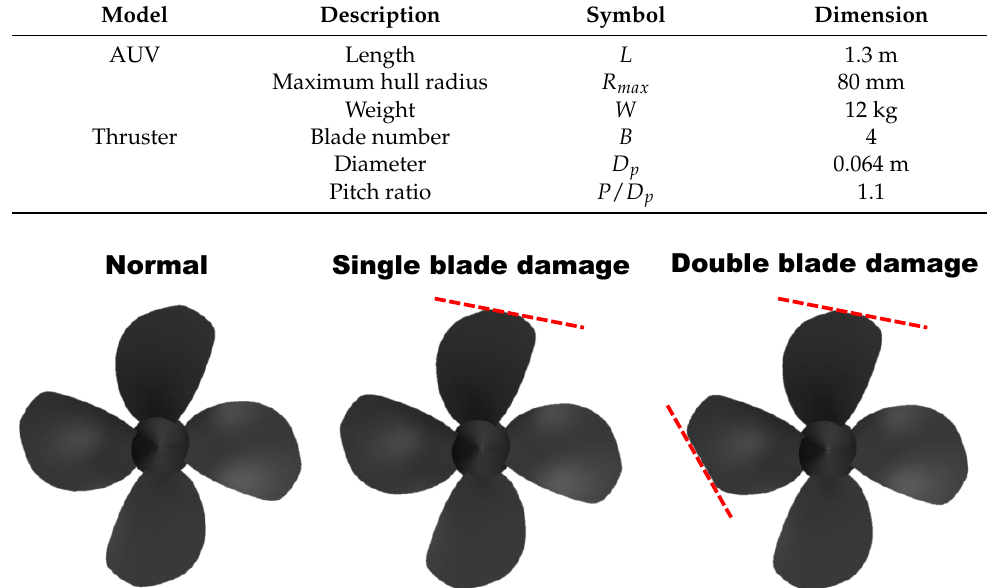
Figure 1. Geometries of AUV and thruster. ( left ) AUV; ( right ) E779A Propeller. Table 1. Specifications of AUV and thruster.